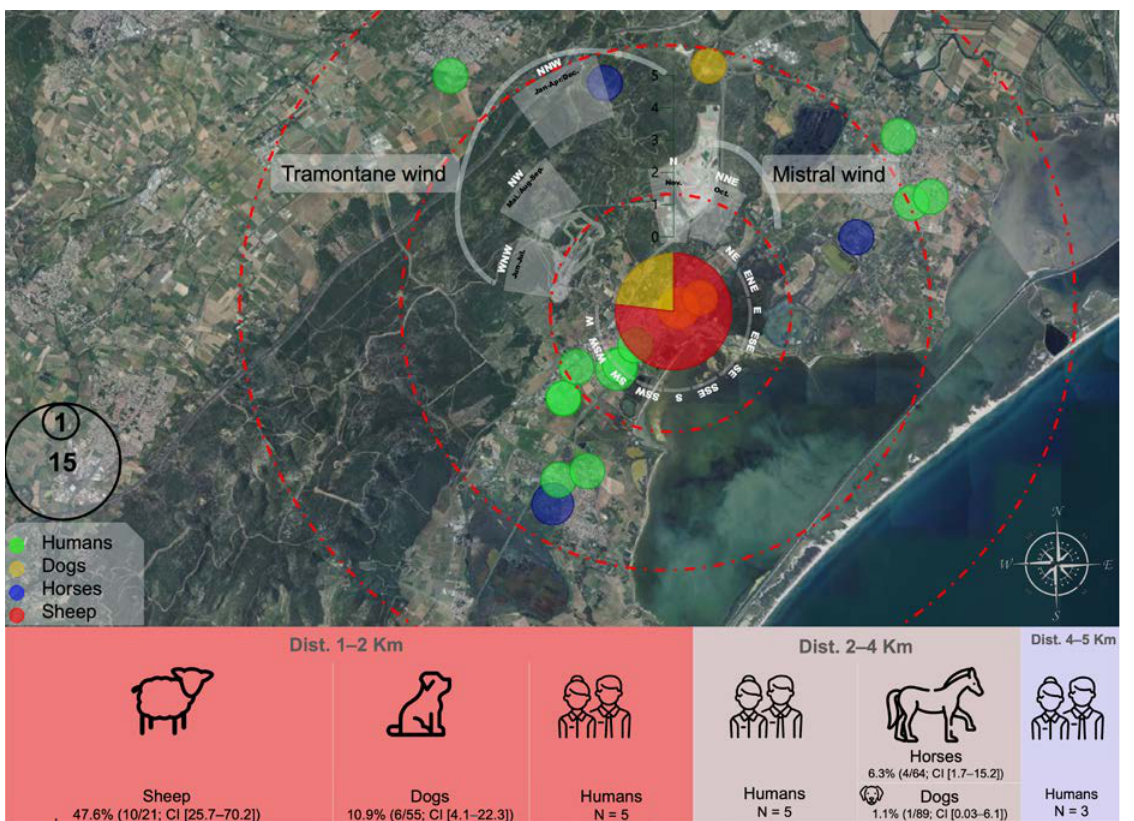
Figure 1. Geographical plotting of human and animal Q fever cases detected in the four French communes (Hérault department). Circles are colour-coded and size-dependent according to the host and number of cases. The wind rose around the sheepfold indicates the name, intensity (wind speed), direction, and annual active periods over the past three years. Geographical locations of both human and animal cases are approximative and do not reflect the exact location of Q fever cases in order to maintain confident iality. Number of human cases (N), seroprevalence as well as 95 CI are provided for each sampled population within 2 Km distance schedules from the sheepfold. Table 5. Seroprevalence in animals and human cases of Q fever around the sheepfold according to 2 km perimeters.